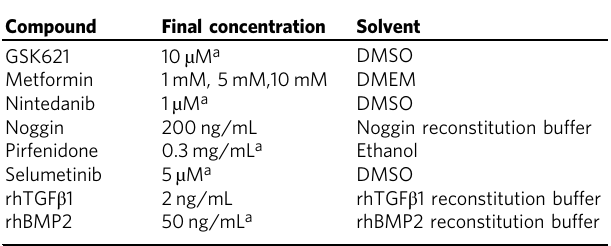
Table 1 Treatment conditions of primary human lung fi broblasts